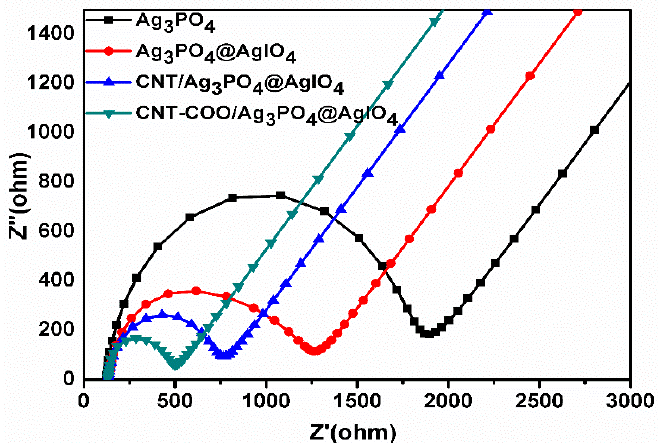
Figure 4. ( a ) DRS spectra of the synthesized materials, and ( b ) the plot of ( α h ʋ ) 2 versus energy (h ʋ ).